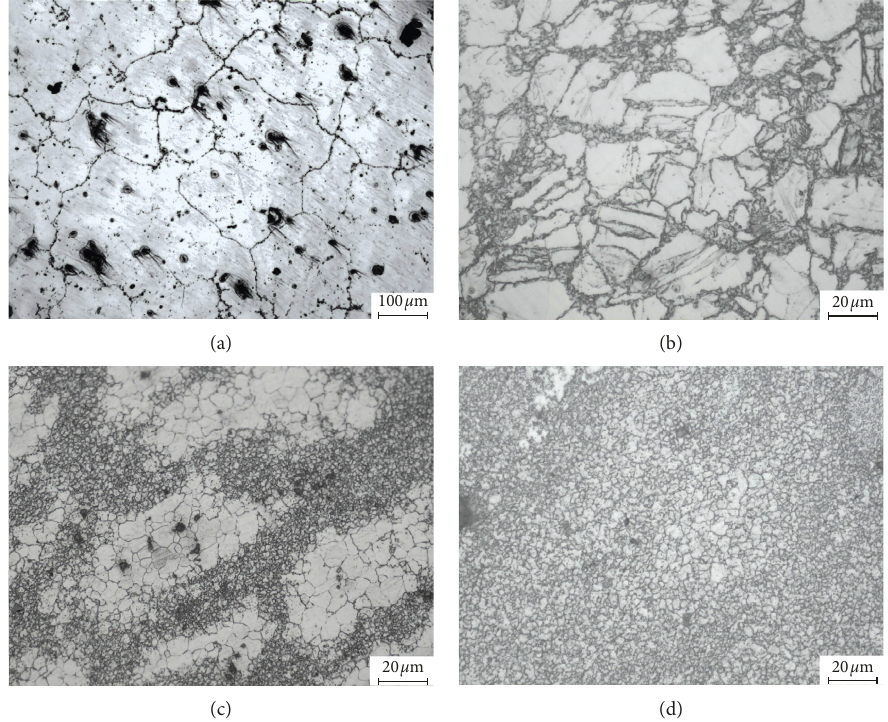
Figure 4: Optical microscope photograph of the samples: (a) the annealed; (b) one-pass CEE; (c) two-pass CEE; (d) three-pass CEE.